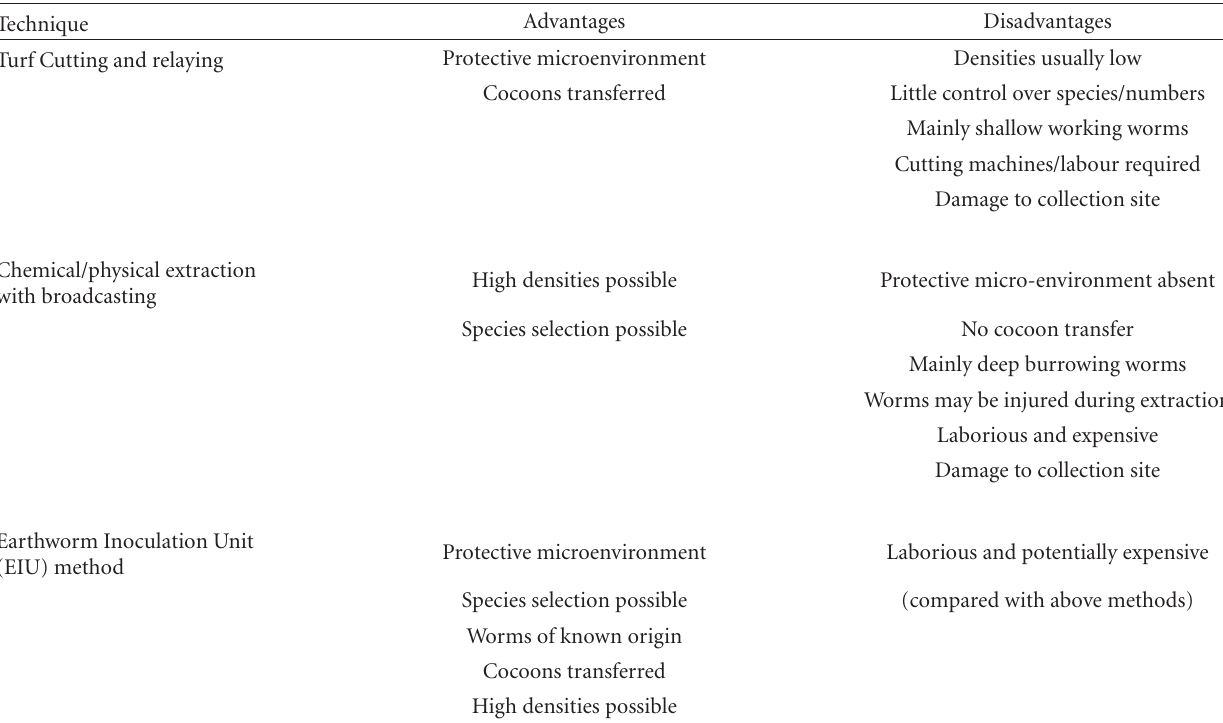
Table 3: Relative Merits of existing Earthworm Inoculation Techniques (adapted from